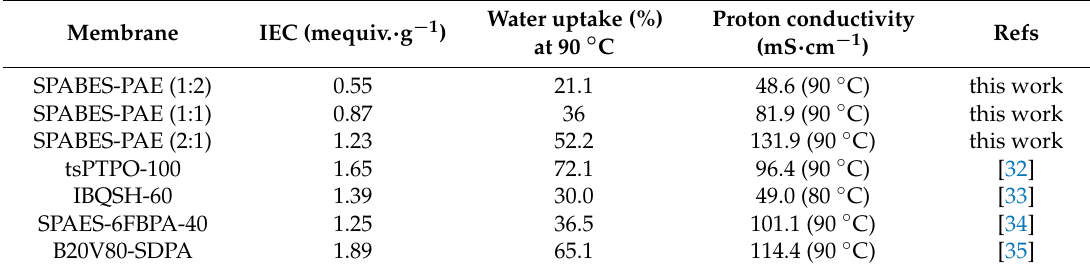
Table 4. IEC, water uptake, and proton conductivity comparison between recently reported proton exchange membranes